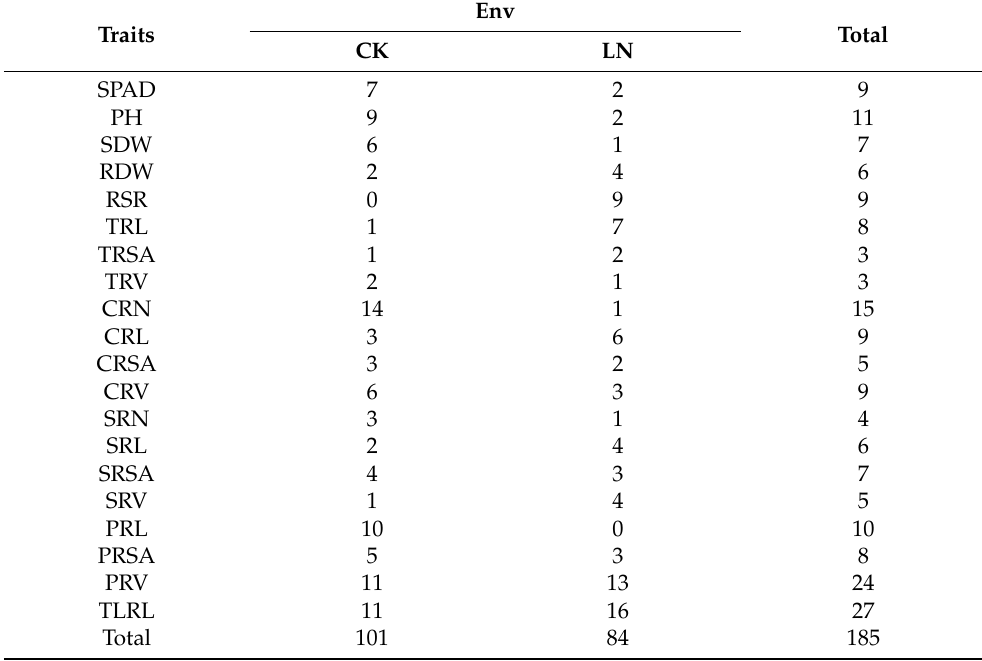
Table 2. Number of significant SNPs detected for each